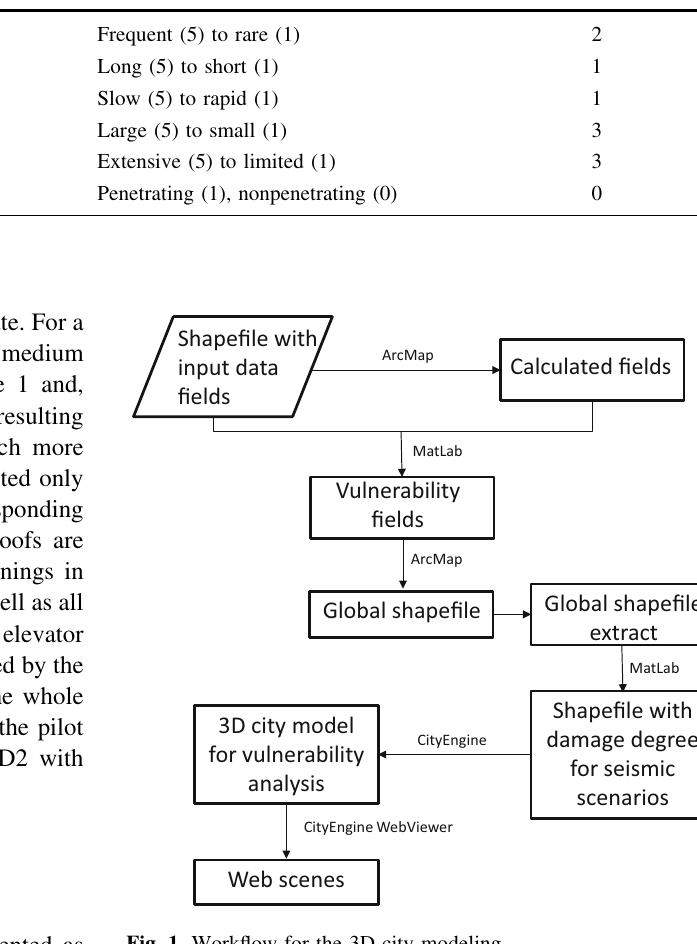
Table 2 Values assigned to decision criteria dependent on Lisbon earthquake hazard Criterion